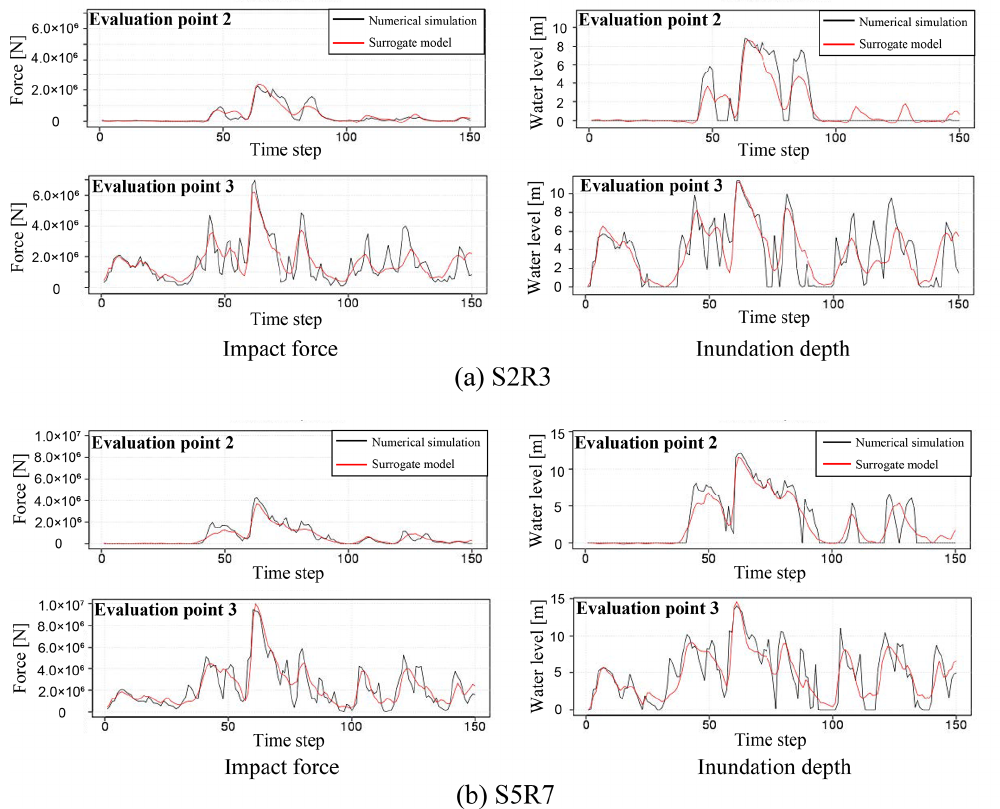
Figure 20. Comparison of time-series data obtained from the numerical analysis and the surrogate models.